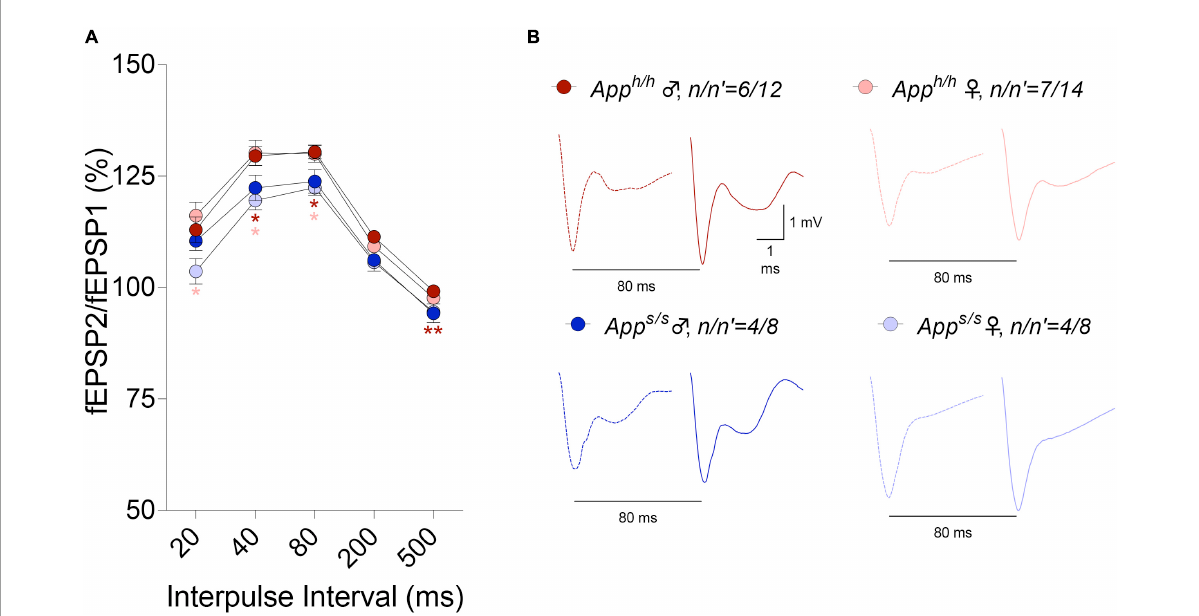
FIGURE9 Analysis of PPR in App h / h and App s / s rats. (A) In App s / s rats, PPR were decreased at 500, 200, 80, and 40 ms IPI compared to control male rats and at 80, 40, and 20 ms IPI compared to control female rats (2-way ANOVA summary, F ( 3 , 38 ) = 4.573, p = 0.0079; post-hoc Tukey’s multiple comparison test: at 500 ms IPI App s / s female vs App h / h male p = 0.0061**, App s / s female vs App s / s male p = 0.9991, App s / s female vs App h / h female p = 0.0798, App h / h female vs App s / s male p = 0.4504, App h / h male vs App s / s male p = 0.1825, App h / h male vs App h / h female p = 0.3847; at 200 ms IPI App s / s female vs App h / h male p = 0.0055**, App s / s female vs App s / s male p = 0.9982, App s / s female vs App h / h female p = 0.0840, App h / h female vs App s / s male p = 0.6325, App h / h male vs App s / s male p = 0.2409, App h / h male vs App h / h female p = 0.0852; at 80 ms IPI App s / s female vs App h / h male p = 0.0137*, App s / s female vs App h / h female p = 0.0364*, App s / s female vs App s / s male p = 0.9683, App h / h female vs App s / s male p = 0.2707, App h / h male vs App s / s male p = 0.1872, App h / h male vs App h / h female p = 0.9982; at 40 ms IPI App s / s female vs App h / h male p = 0.0203*, App s / s female vs App h / h female p = 0.0317*, App s / s female vs App s / s male p = 0.8634, App h / h female vs App s / s male p = 0.2400, App h / h male vs App s / s male p = 0.2340, App h / h male vs App h / h female p = 0.9971; at 20 ms IPI App s / s female vs App h / h male p = 0.1407, App s / s female vs App h / h female p = 0.0345*, App s / s female vs App s / s male p = 0.2703, App h / h female vs App s / s male p = 0.4372, App h / h male vs App s / s male p = 0.8996, App h / h male vs App h / h female p = 0.8708). (B) Representative traces of fEPSP evoked at 80 ms IPI are shown. Dotted lines represent the response after the first stimulation and solid lines represent the second responses. Data are represented as mean ± SEM. Data were analyzed by two-way ANOVA for repeated measures followed by post-hoc Tukey’s multiple comparisons test when ANOVA showed statistically significant differences. n = number of animals; n (cid:48) = number of